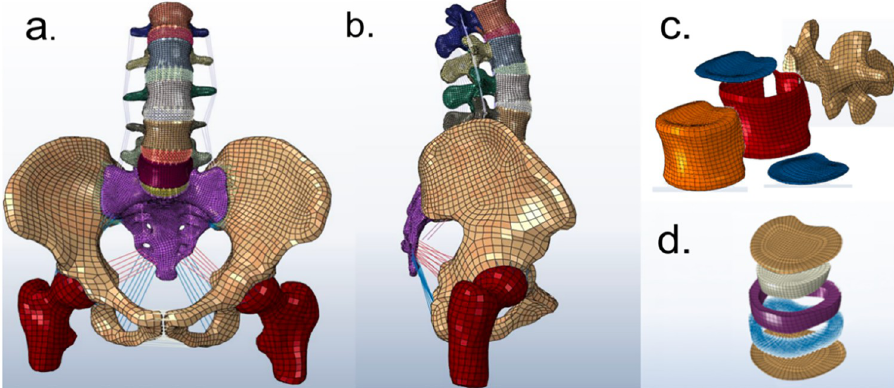
Fig 3. (a) Front and (b) lateral views of the FE model of the lumbar-pelvis; (b) Schematic of (c) the annulus fibrosis and (d) vertebra